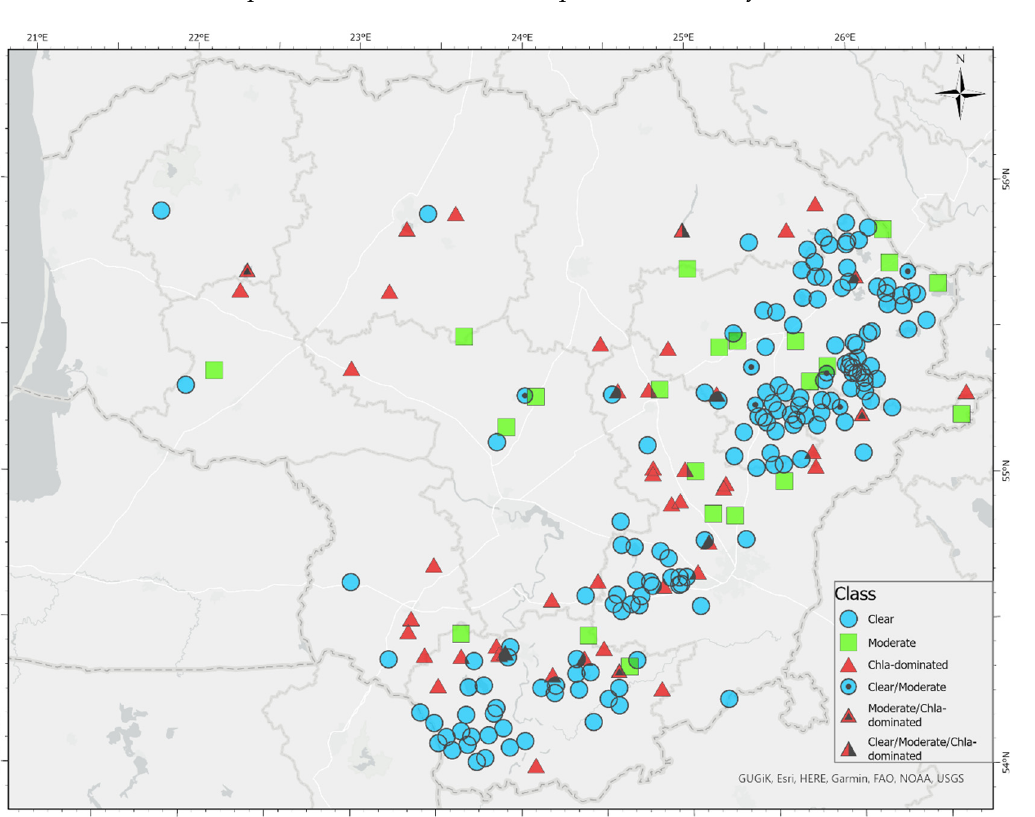
Figure 6. Class changes based on in situ (circles) and model (squares) data in lakes with the preva- lent Chla-dominated class in the year of 2020 when Clear or Moderate classes were observed in these lakes. The grey observation of class in lake Pluvija is beyond the definition of four (Clear, Moderate, Chla-dominated, and Turbid) classes used in this study. 4. Discussion